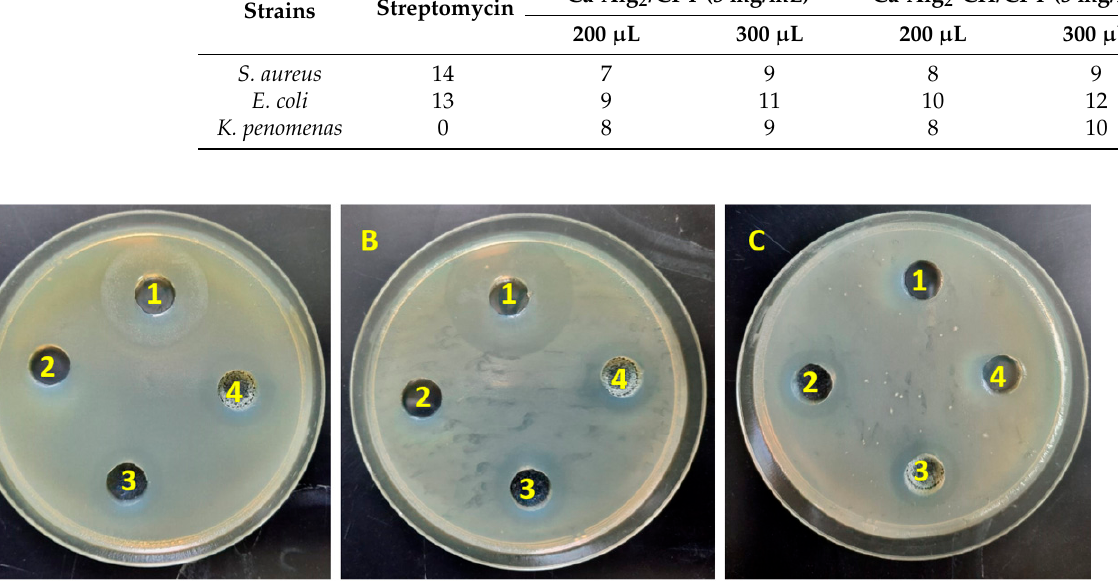
Figure 5. Inhibition zone of different Polymer types (Ca-Alg 2 /CPT and Ca-Alg 2 -CH/CPT) of against ( A )) Staphylococcus aureus , ( B ) E. coli , and ( C ) klebsiella penomenas . 1 = 1.2 µg/mL of Streptomycin, 2 = DMSO only, 3 = Ca-Alg 2 /CPT (3 mg/mL) and 4 = Ca-Alg 2 -CH/CPT (3 mg/mL).